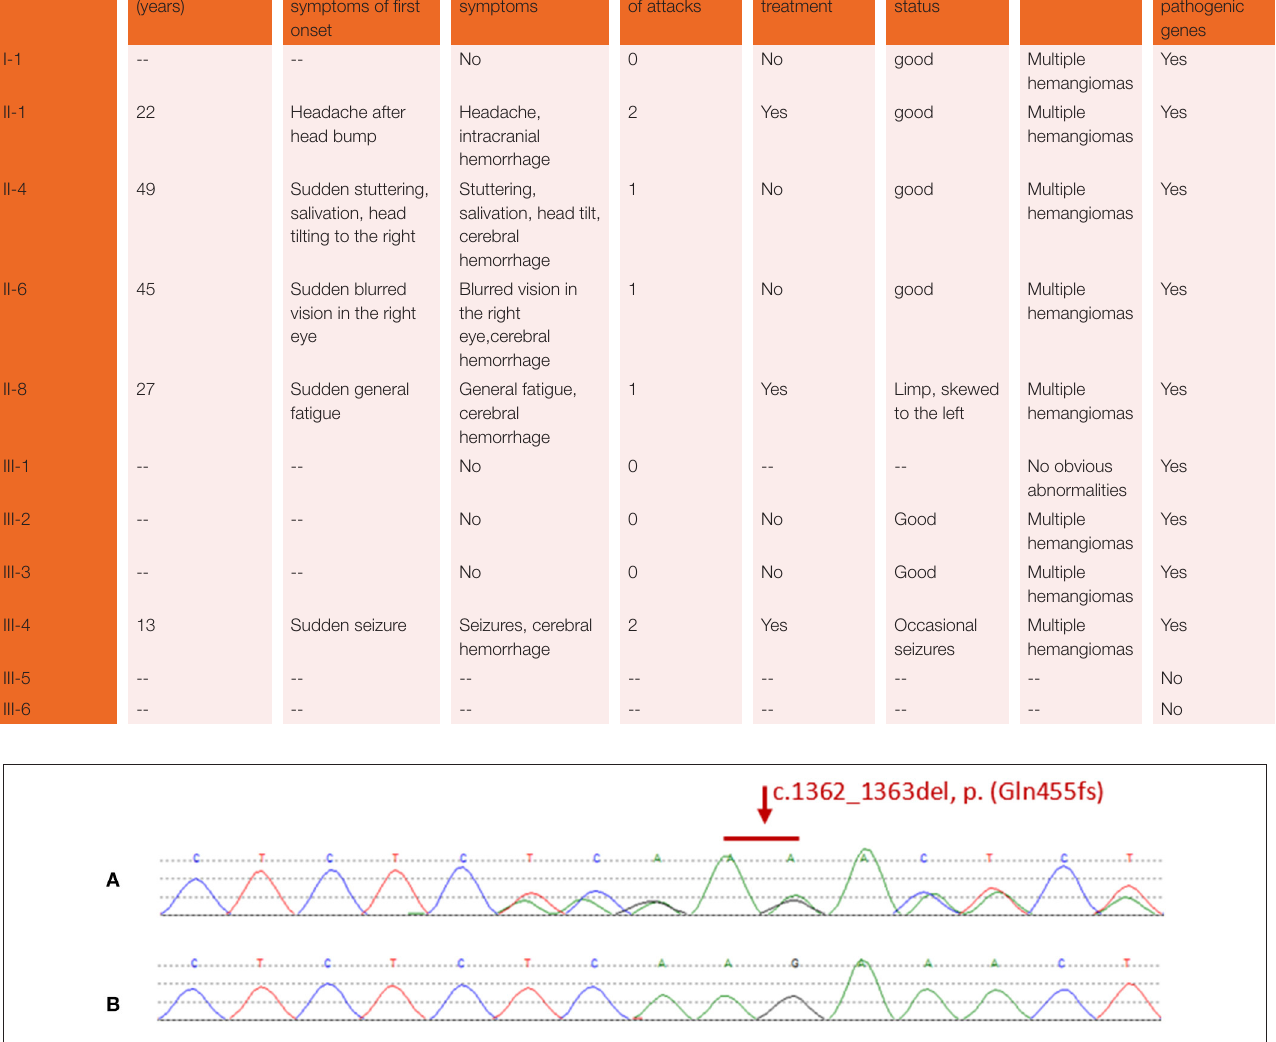
TABLE 2 | The incidence, diagnosis, treatment, and prognosis of family members. Items